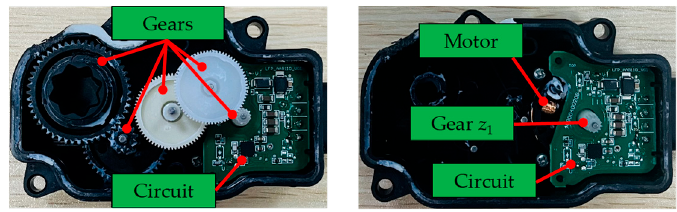
Figure 1. The structure of the grille controller. Table 1. The number of teeth and rotation frequency of each gear.